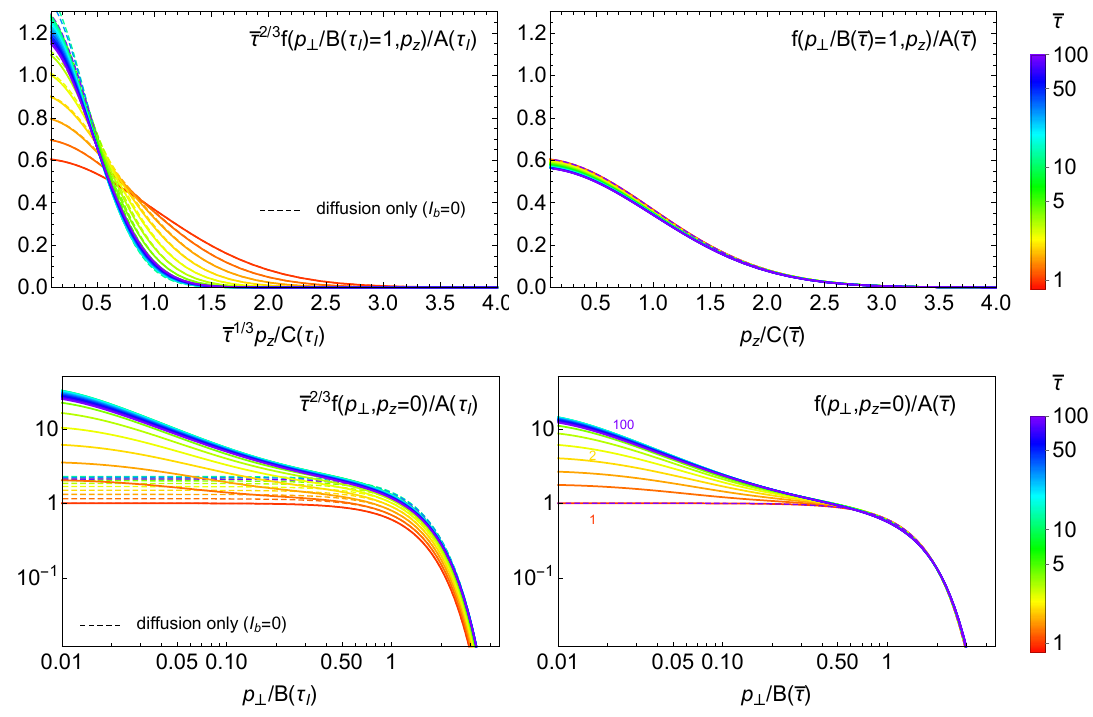
Figure 3 . The rescaled distribution function w (2.1) for the numerical solutions of the Fokker-Planck equation with ( g s , σ 0 ) = (10 − 3 , 0 . 1) . The left panel shows the results with A, B, C determined by the BMSS exponent while the right panel shows the same but with time-dependent scaling exponents extracted from figure 2. Colors show the evolution in the rescaled time coordinate ¯ τ . Dashed curves show the analytic scaling solution obtained for I b = 0 , i.e., eq. (4.10), that has no dependence on τ , as shown later in this